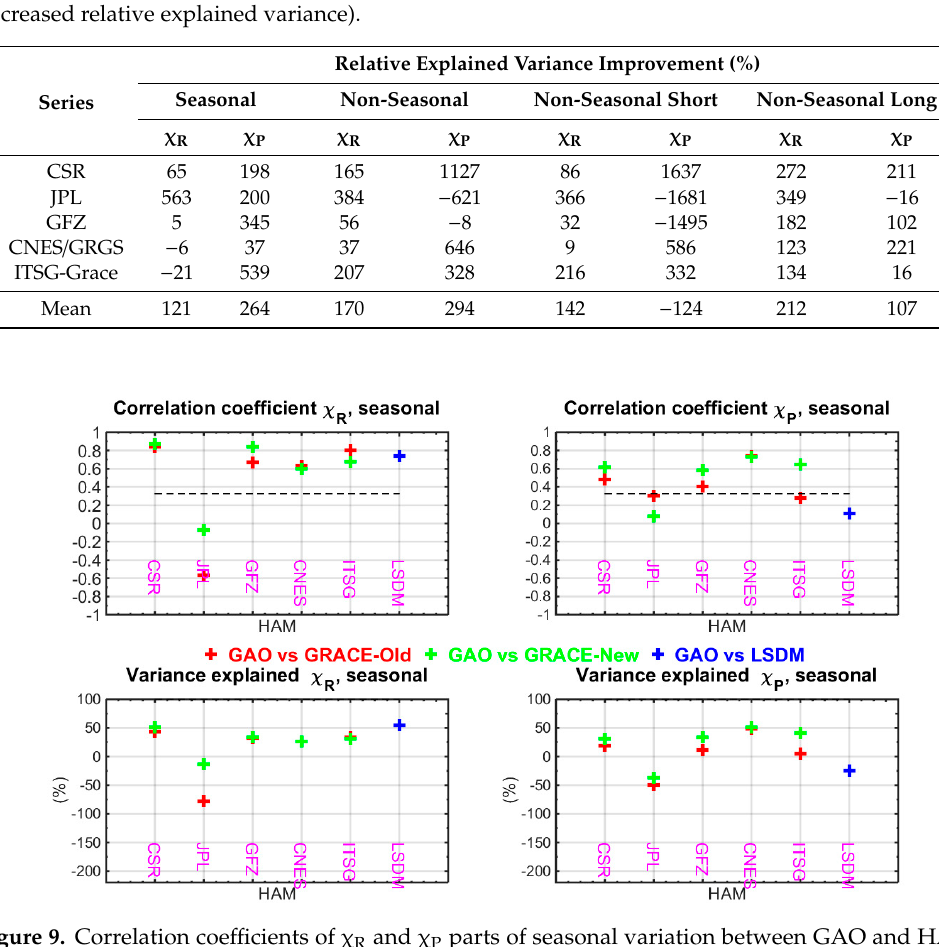
Figure 9. Correlation coe ffi cients of χ R and χ P parts of seasonal variation between GAO and HAM computed from GRACE solutions and the LSDM and percentage of variance in GAO explained by HAM functions. The critical value of the correlation coe ffi cient for 25 independent points and a confidence level of 0.95 was 0.34. The standard error of the di ff erence between two correlation coe ffi cients for 25 independent points was